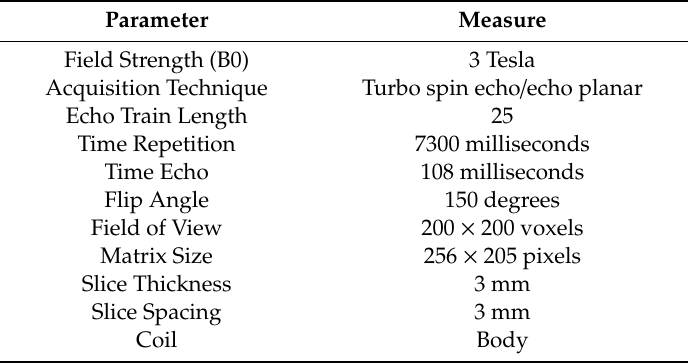
Table 1. Magnetic resonance imaging (MRI) acquisition